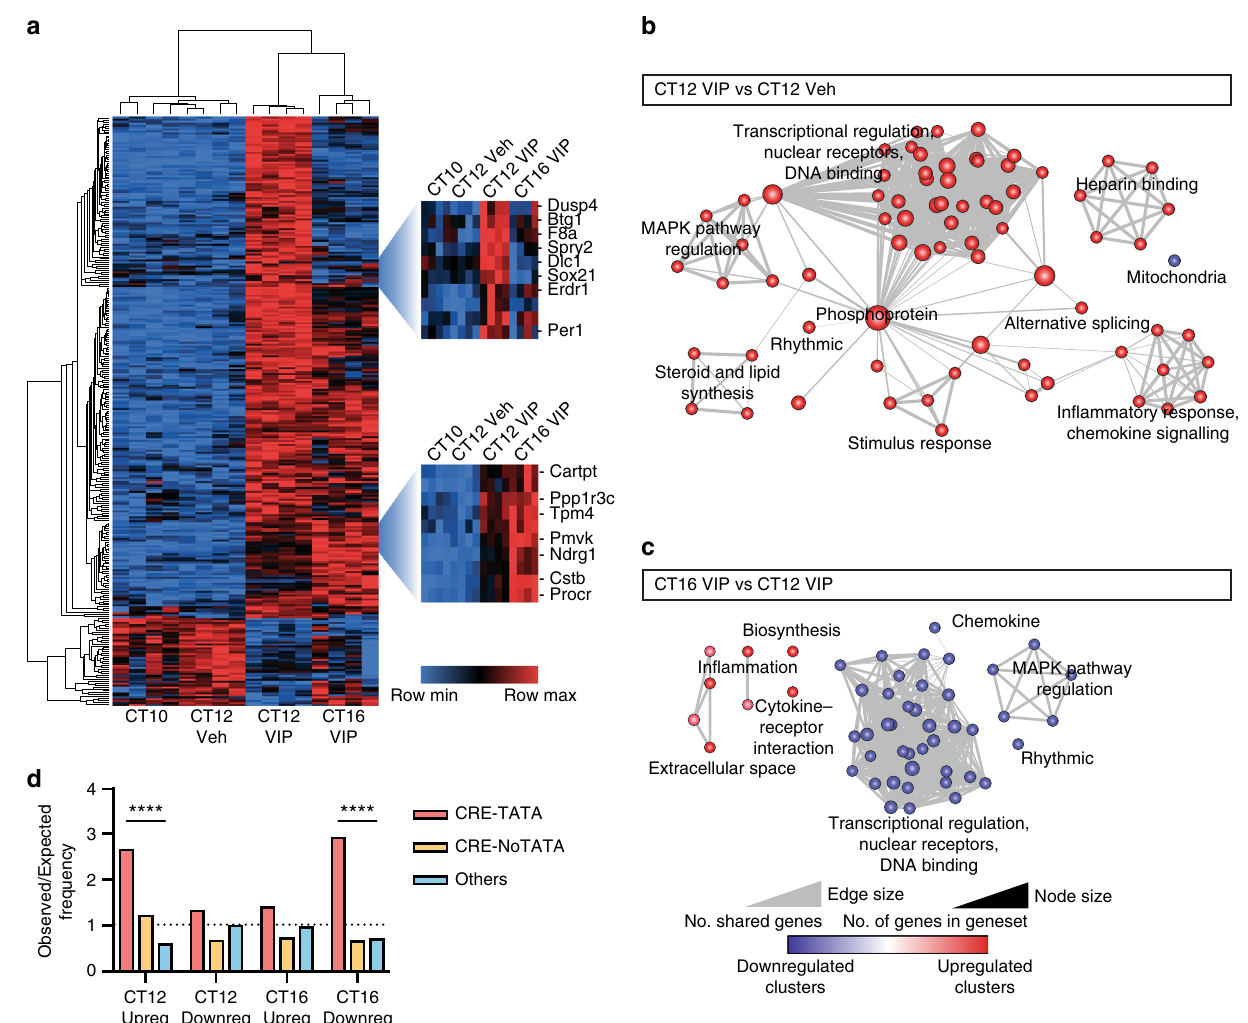
Fig. 3 VIP-induced gene networks and cellular signalling pathways in SCN. a Hierarchically clustered heatmap of top 300 most signi fi cantly altered genes in CT12 VIP vs. CT12 Veh comparison across time and treatment using globally normalised probe expression levels. Two regions are enlarged: the top displays genes acutely upregulated 2 h after VIP treatment before returning to baseline levels, the bottom shows genes which continue to be upregulated after 6 h. Within each gene row, transcript levels have been normalised to the minimum (blue) and maximum (red) values for that given gene. b , c Functional annotation of genes signi fi cantly altered by VIP treatment after 2 h ( b ; 738 genes) and after 6 h ( c ; 342 genes) using DAVID functional annotation and visualised using the enrichment map plugin for Cytoscape. d Enrichment of CREs in the promoters of signi fi cantly regulated genes, displayed as observed/expected frequency, with expected values based on ratios of the appearance of promoter elements across all genes detected on the microarray at CT12 VIP vs. CT12 Veh. CRE-TATA: CRE within 300 bp of TATA box; CRE-NoTATA: CRE in promoter further upstream; Others: No